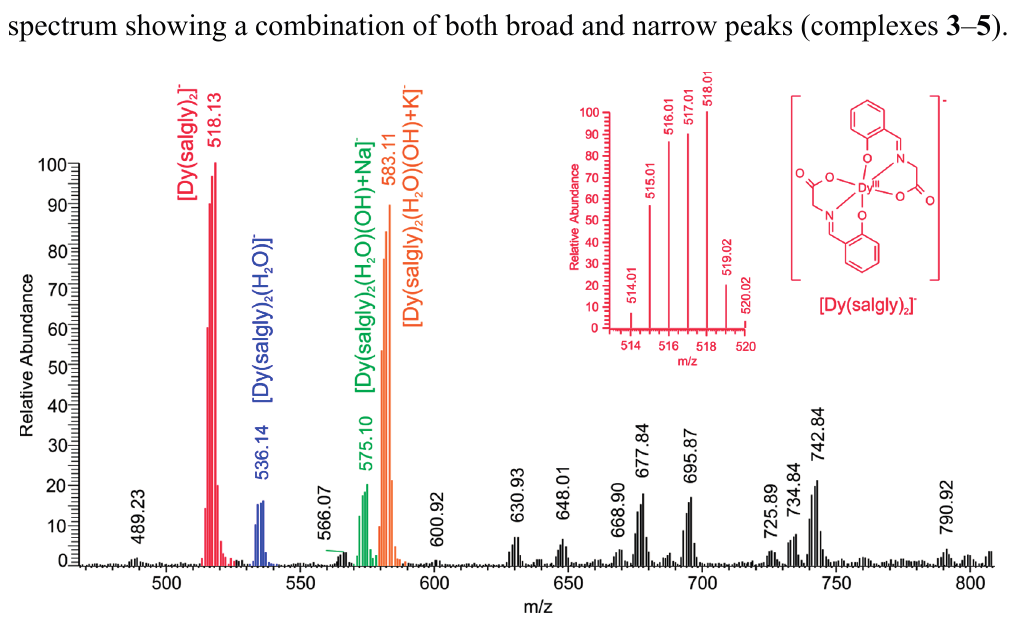
Figure 5. The example of the electrospray-ionization mass spectrum of K[Dy(salgly) 2 (H 2 O) 2 ] · H 2 O ( 3 ). Inset represents the ideal isotopic distribution corresponding to the species